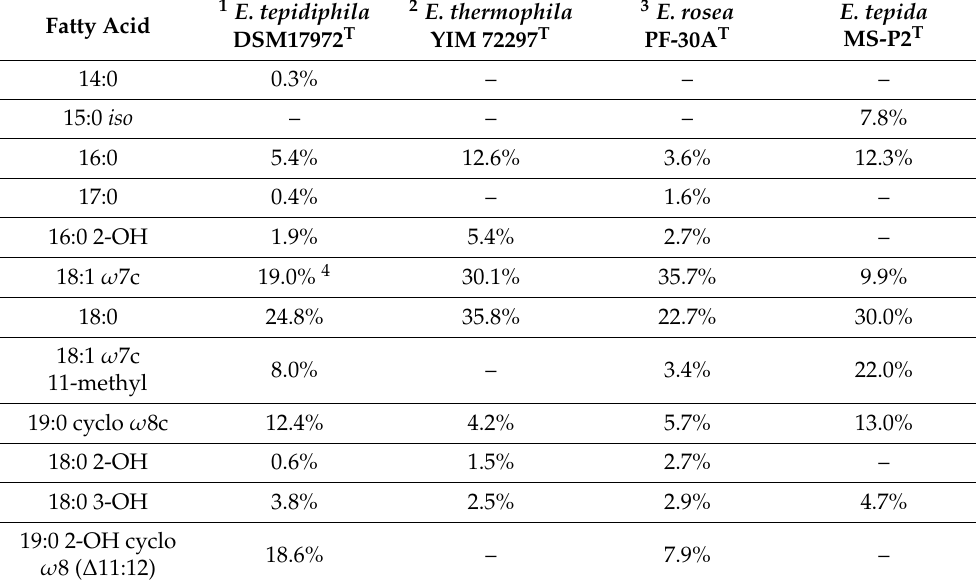
Table 2. Fatty acid composition of Elioraea species type